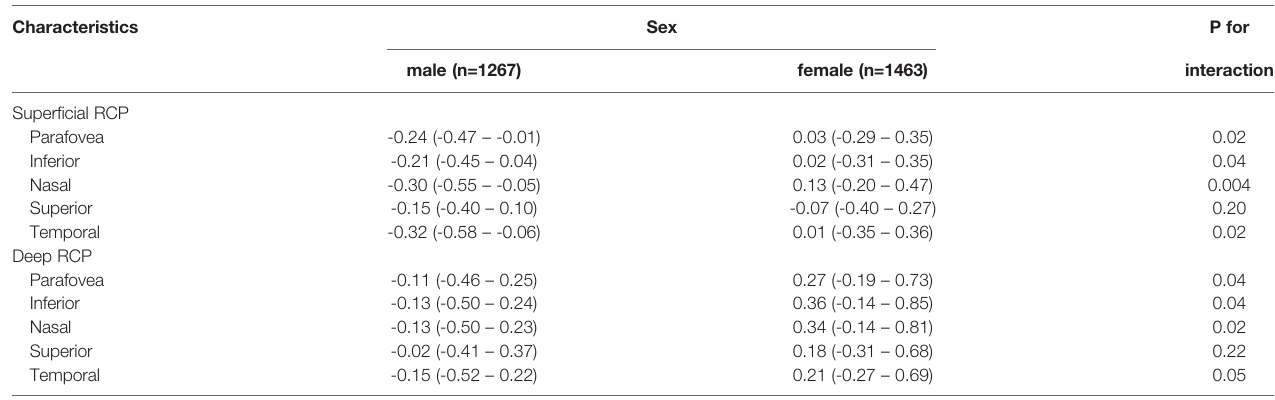
TABLE 6 | Association between hyperuricemia and retinal capillary plexus.